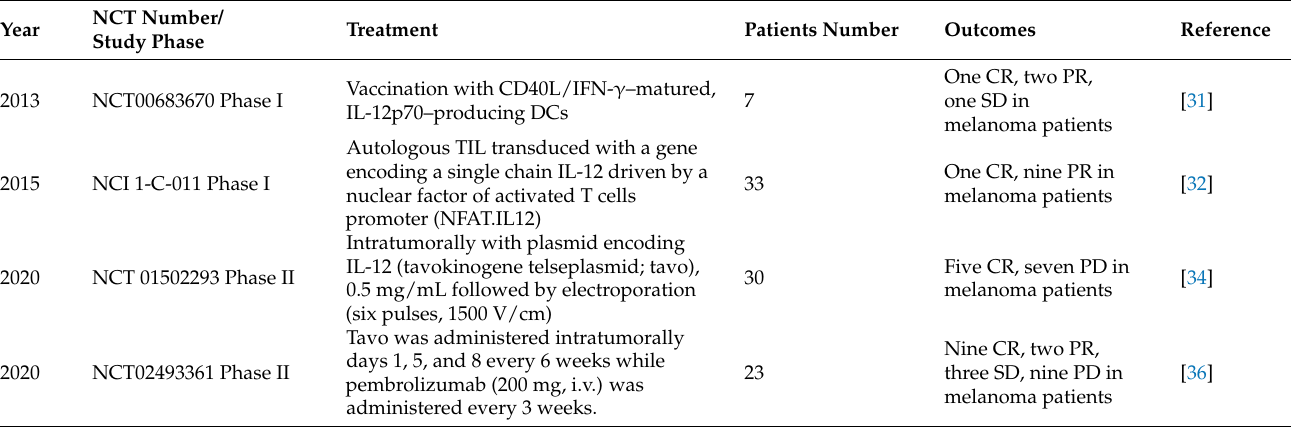
Table 1. Clinical trials in melanoma patients with IL-12 therapy since